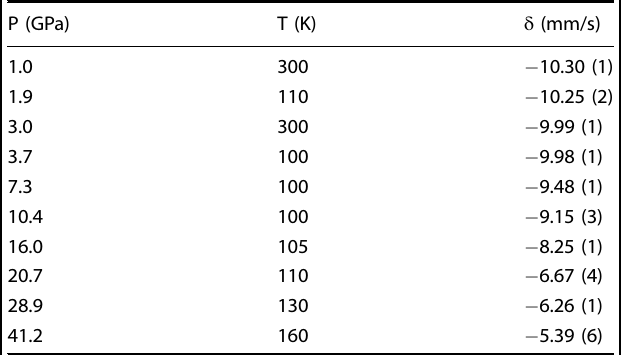
41.2 − 5.39 (6) Uncertainties are from CONUSS fi tting